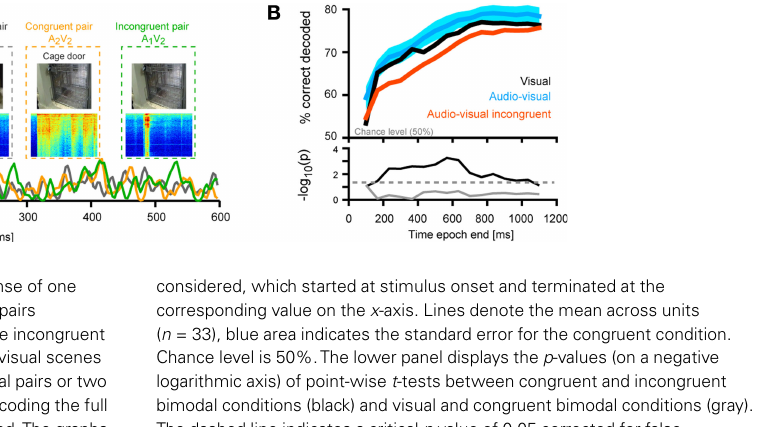
considered, which started at stimulus onset and terminated at the corresponding value on the x -axis. Lines denote the mean across units ( n = 33), blue area indicates the standard error for the congruent condition. Chance level is 50%. The lower panel displays the p -values (on a negative logarithmic axis) of point-wise t -tests between congruent and incongruent bimodal conditions (black) and visual and congruent bimodal conditions (gray). The dashed line indicates a critical p -value of 0.05 corrected for false discovery rate (for the black